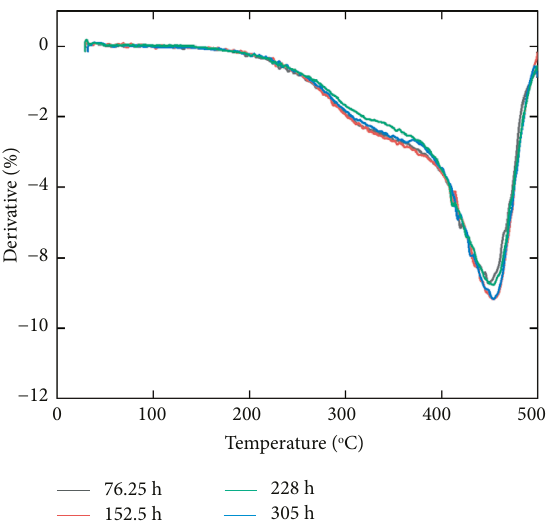
Figure 12: DTG curves of ASA-modified asphalt under different UV aging times. Table 4: TG evaluating indices of ASA-modified asphalt under different UV aging